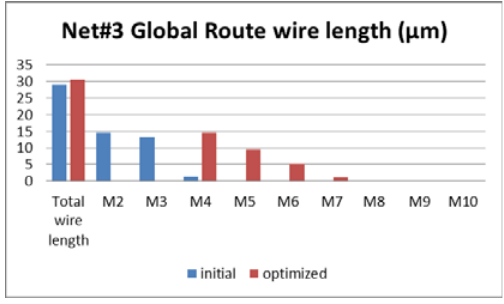
Figure 10. Net#3 global route wire length distribution.